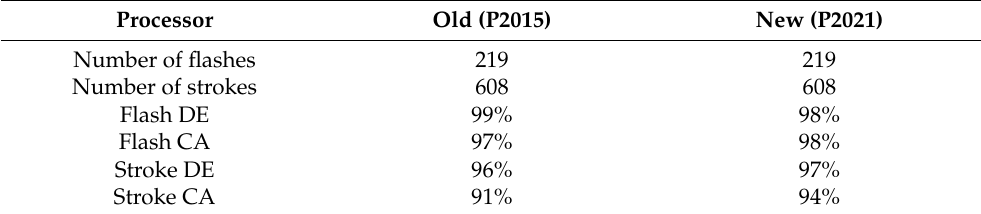
Table 2. Summary of performance characteristics of P2015 and P2021 evaluated using natural lightning.